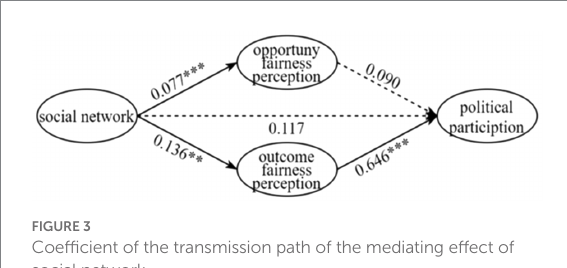
FIGURE 2 Coefficient of the transmission path of the mediating effect of social trust.